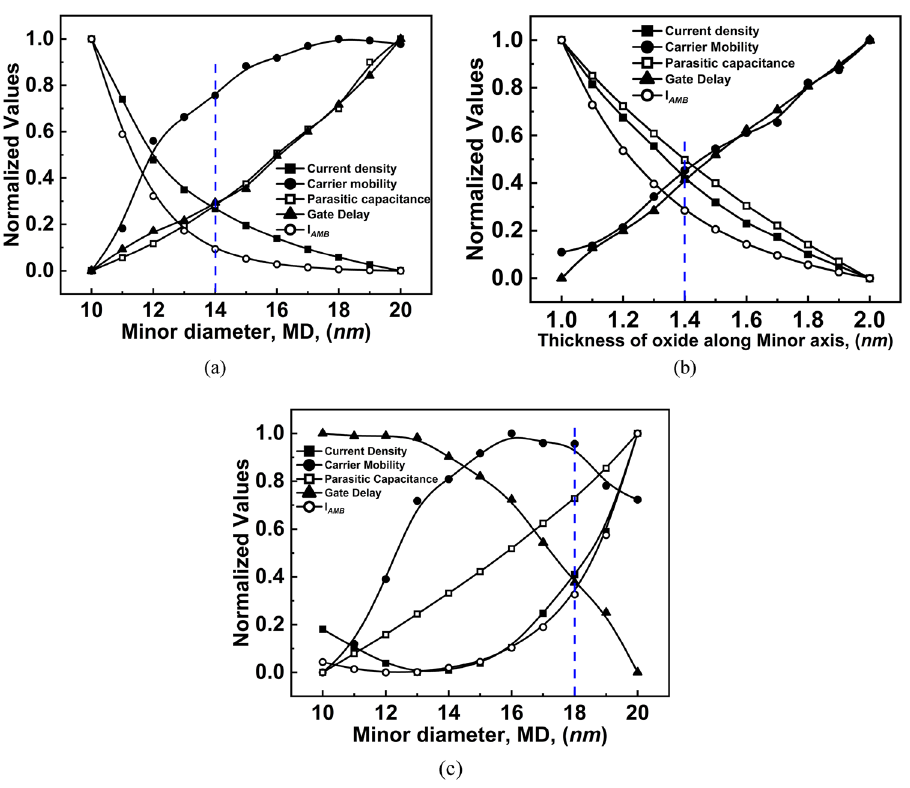
Figure 5. Normalized values for different eGAA TFET along: ( a ) MD for EOEC optimization, ( b ) MA of EOCC structure for gate oxide thickness optimization, ( c ) MD for COEC